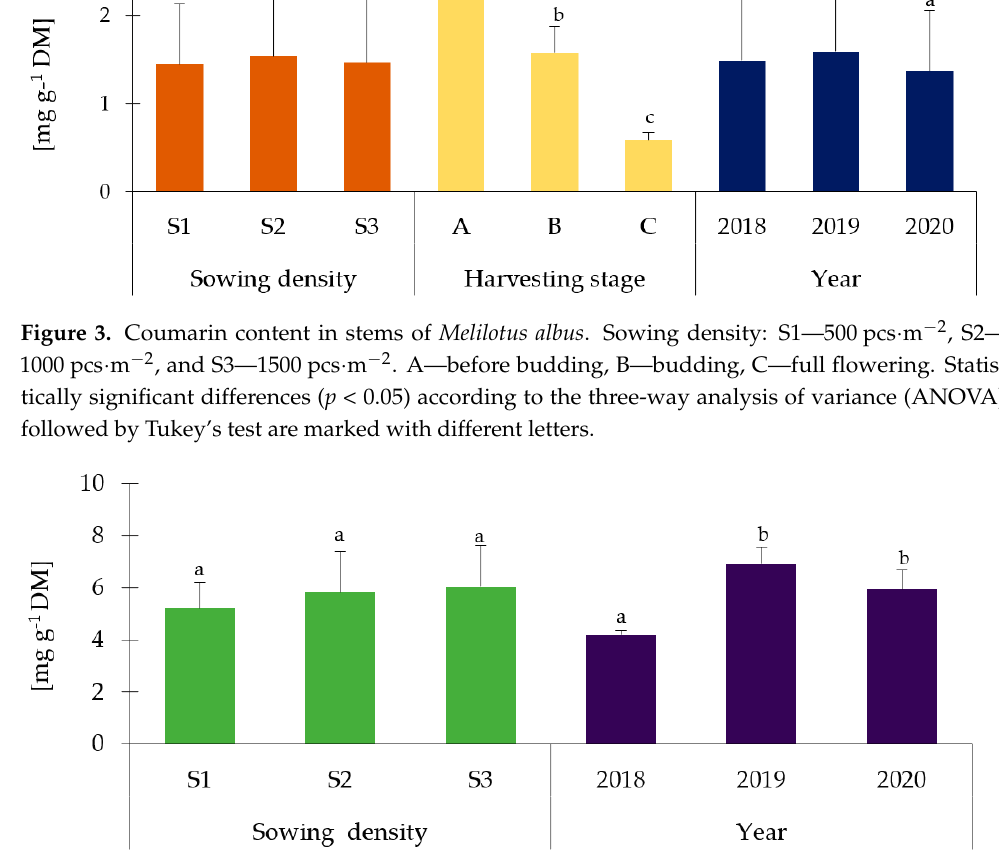
Figure 4. Coumarin content in flowers of Melilotus albus . Sowing density: S1—500 pcs · m − 2 , S2—1000 pcs · m − 2 , and S3—1500 pcs · m − 2 . Statistically significant differences ( p < 0.05) according to the two-way analysis of variance (ANOVA) followed by Tukey’s test are marked with different letters.